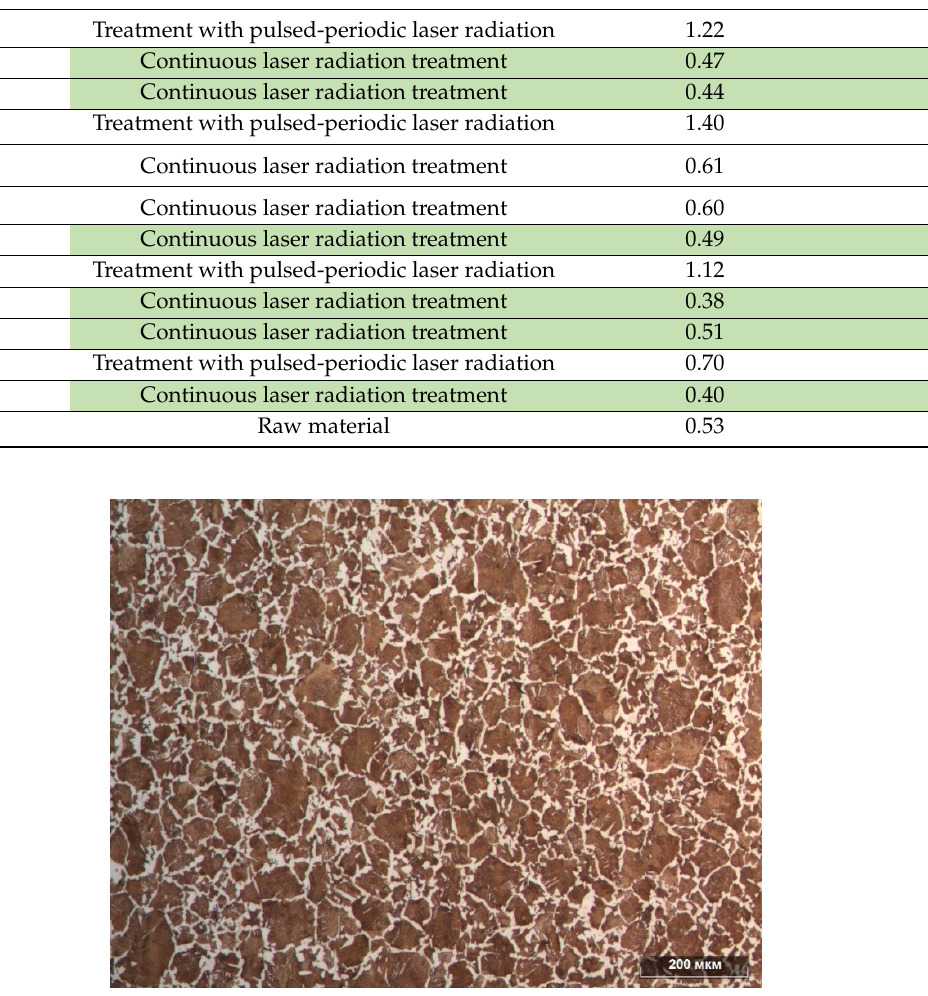
Figure 3. The surface of the etched micro-sections under a microscope at 100× magnification.